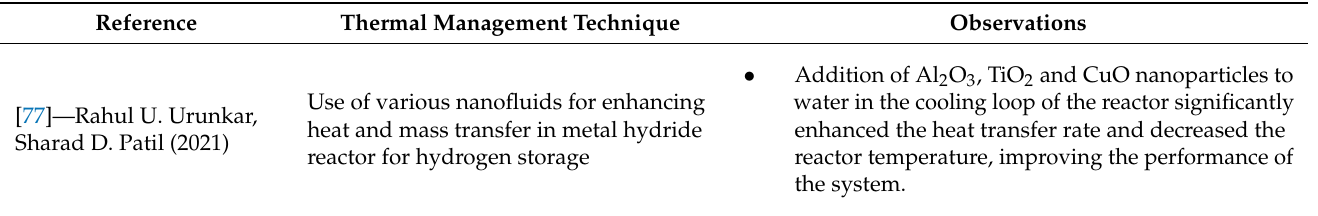
Table 2. Some examples of phase change material